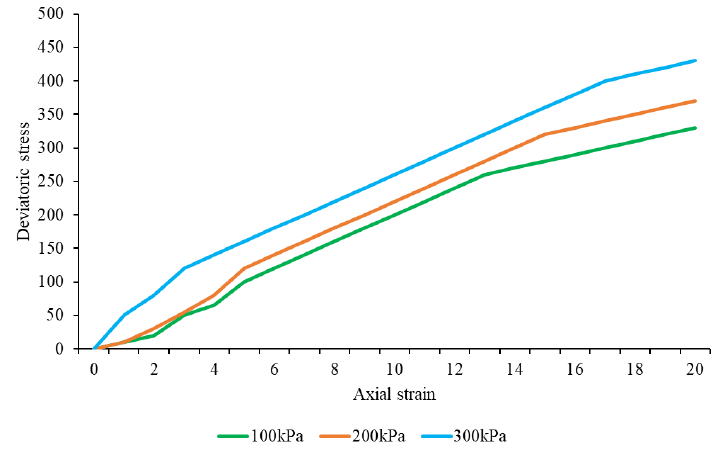
Figure 4. Clay deviatoric stress curves under different confining pressures.